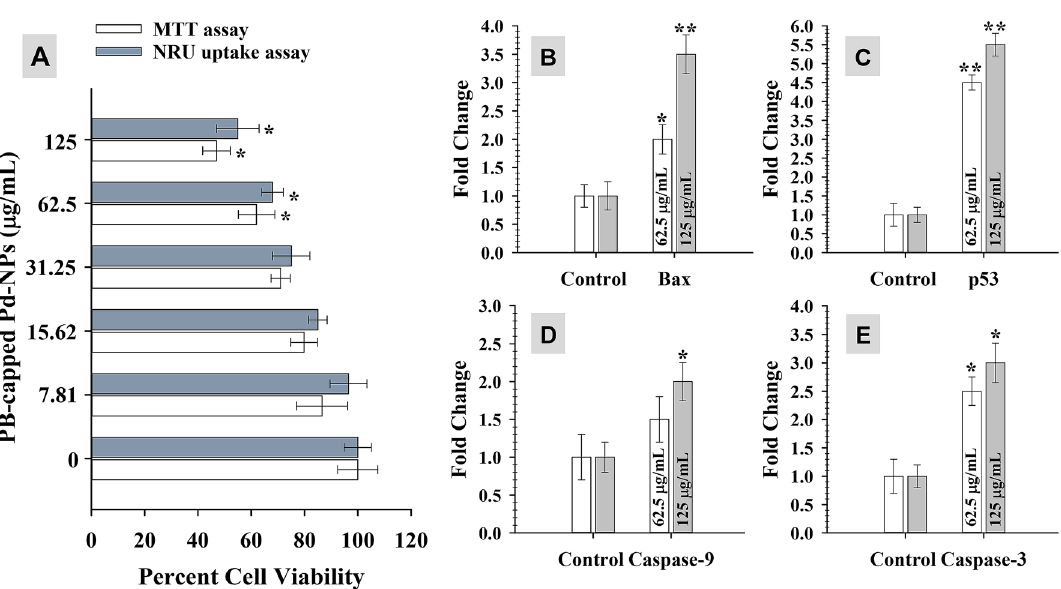
Figure 10. Anti-cancer activity of PB extract-capped Pd-NPs in a concentration (7.81–250 µg/mL) dependent manner as measured by MTT and NRU assays (panel A). Panels B-E shows fold changes in gene expression of four apoptotic genes ( bax , p53 , caspase‑9 , and caspase‑3 ). Data represents mean values of three independent replicates and error bars represent standard deviation (S.D.). * P ≤ 0.05 and ** P ≤ 0.01 as calculated by student’s